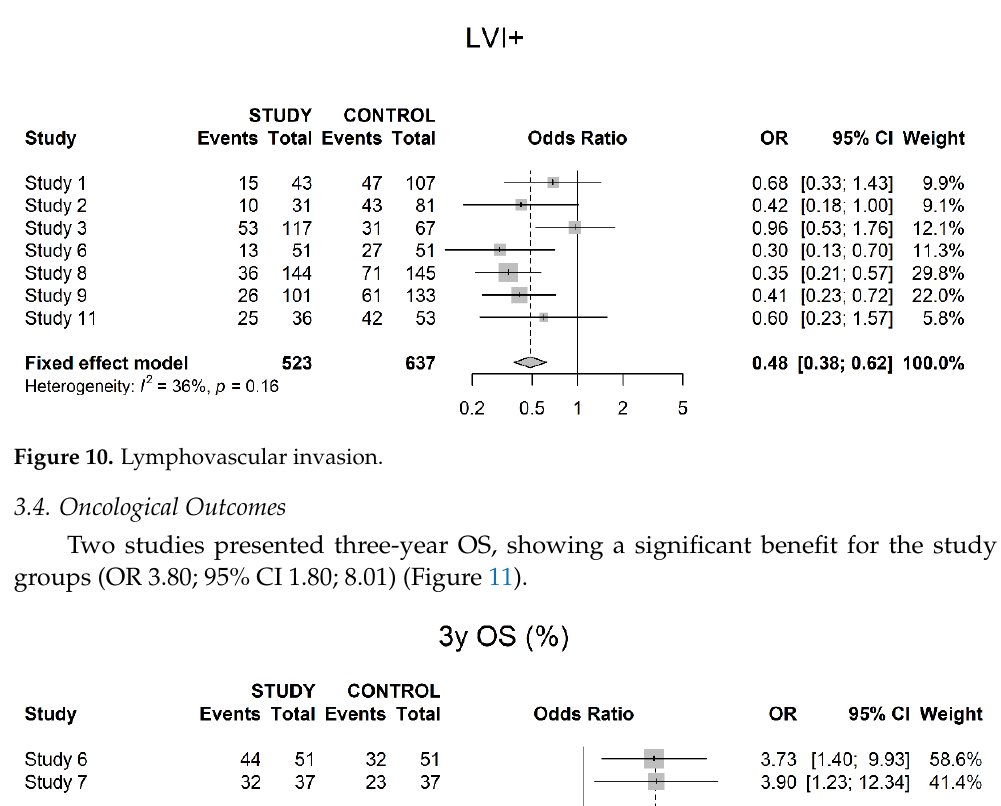
Figure 9. Overall pathological downstaging.